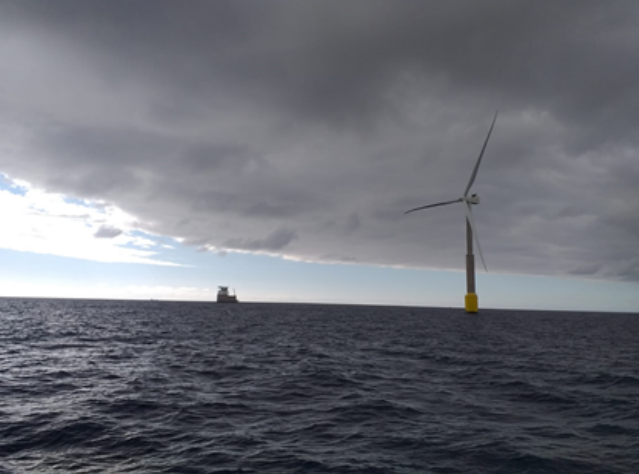
Figure 18. Photo of the ELICAN